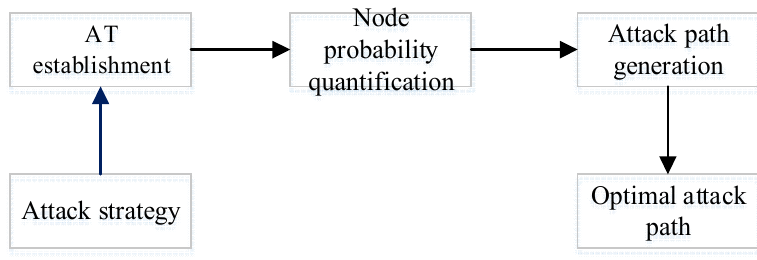
Figure 3. The main stages of the DAS AT Model.